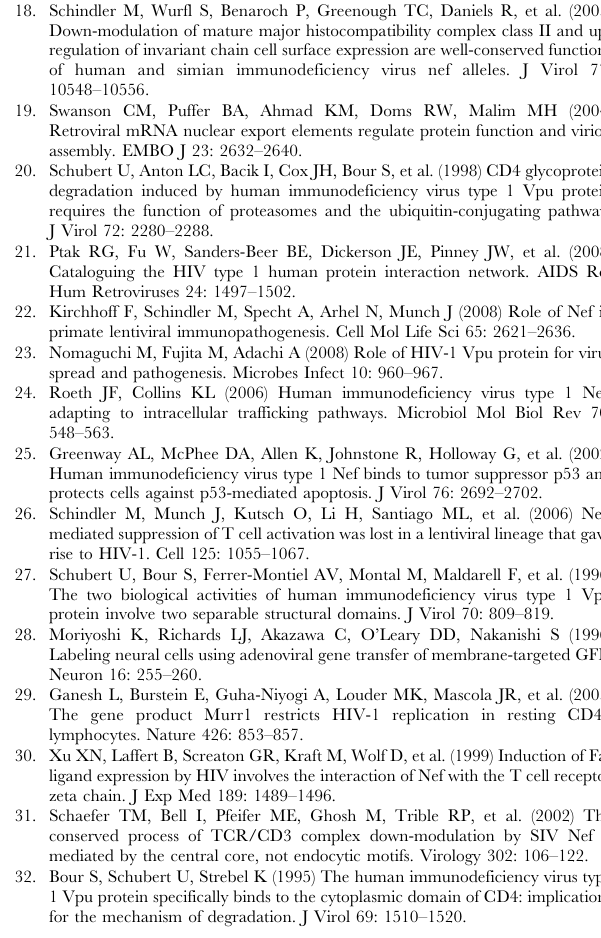
were immunoprecipitated with a rabbit anti-Vpu serum (43) and blotted for the presence of CD317 with anti-FLAG. Figure S5 Biological activity of HIV-1 Rev CFP/YFP fusion proteins. 293T cells were transfected with the indicated CFP/YFP fusion proteins and co-transfected with the Gag expression vector GPV-RRE (36) and a CMV-SEAP reporter construct. Released p24 was measured by ELISA and normalized to transfection efficiency by determining the levels of SEAP (secreted alkaline phosphatase). Error bars represent the SD of triplicates from one representative out of two independent experiments. Found at: doi:10.1371/journal.pone.0009344.s005 (0.19 MB